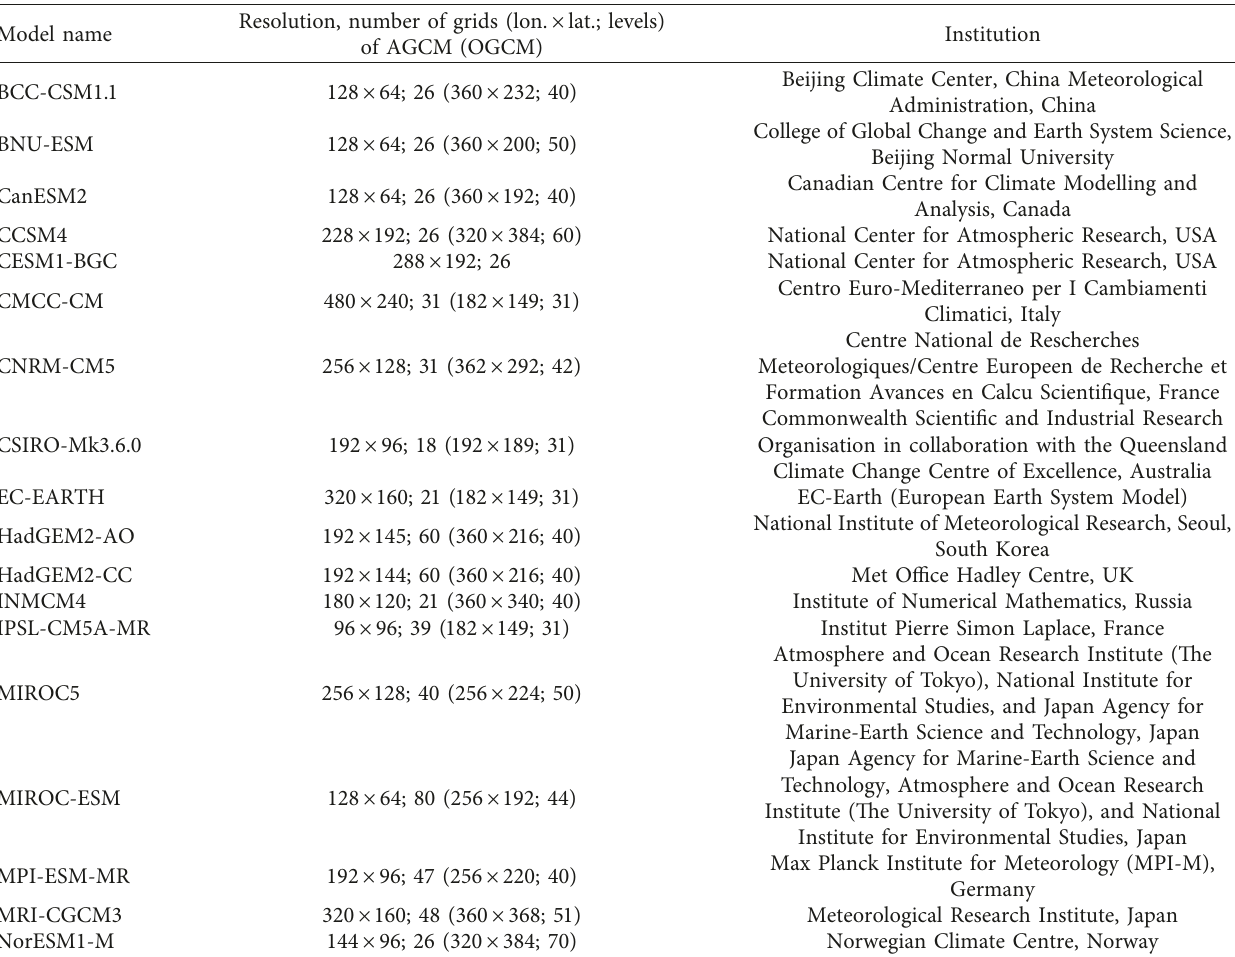
Table 1: Details of models used in the study (the descriptions are from Taylor et al. [42]), showing models’ spatial resolution for the Atmospheric Global Climate Model (AGCM) and Oceanic Global Climate Model (OGCM) and the various institutions that produced the